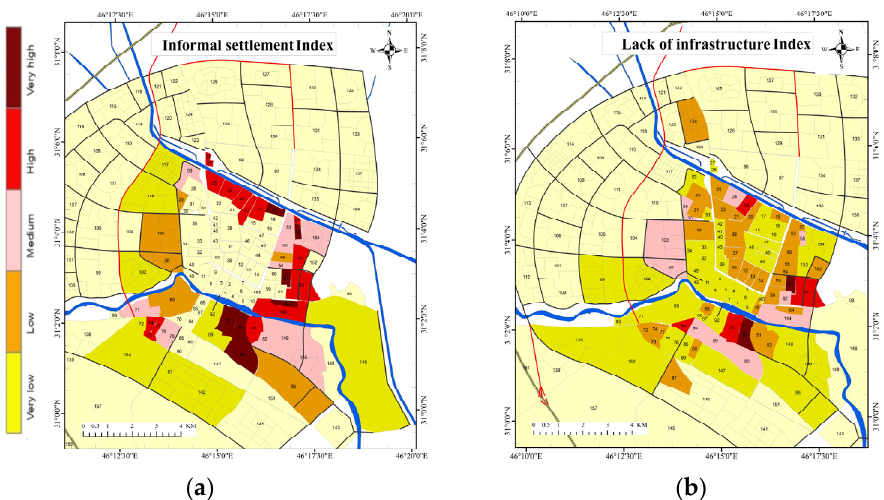
Figure 15. Sub-criteria of the building domain: ( a ) informal settlement rate (C5) and ( b ) lack of infra-structure rate (C6).